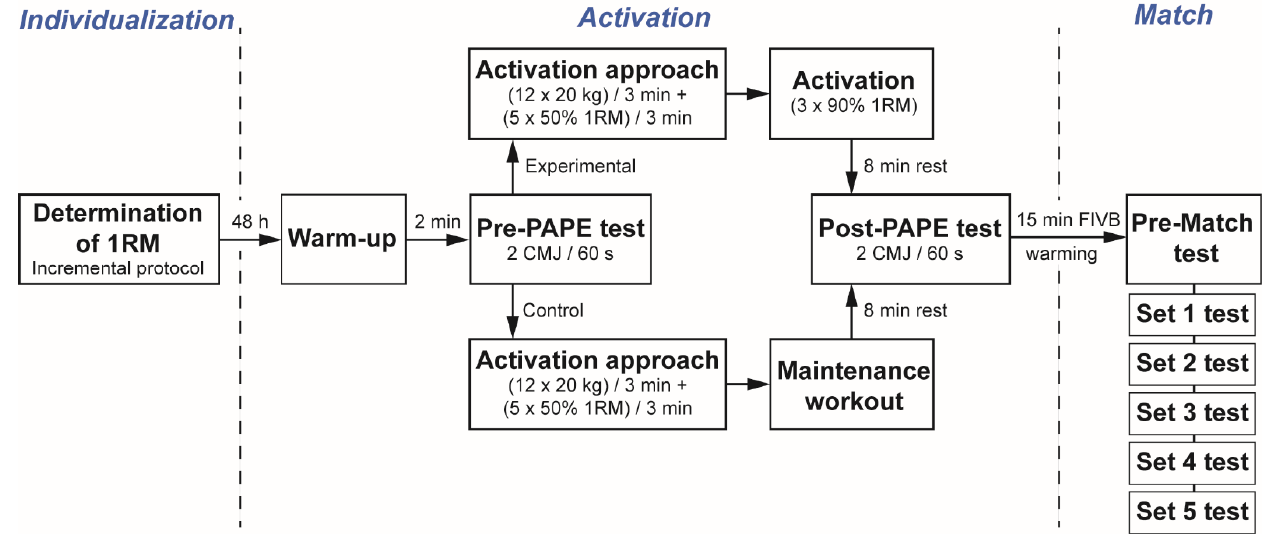
Figure 1. Experimental design of the study¸ RM: Repetition maximum; CMJ: Countermovement jump; PAPE: Post-activation performance enhancement FIVB: Fedération Internationalle de Volleyball.